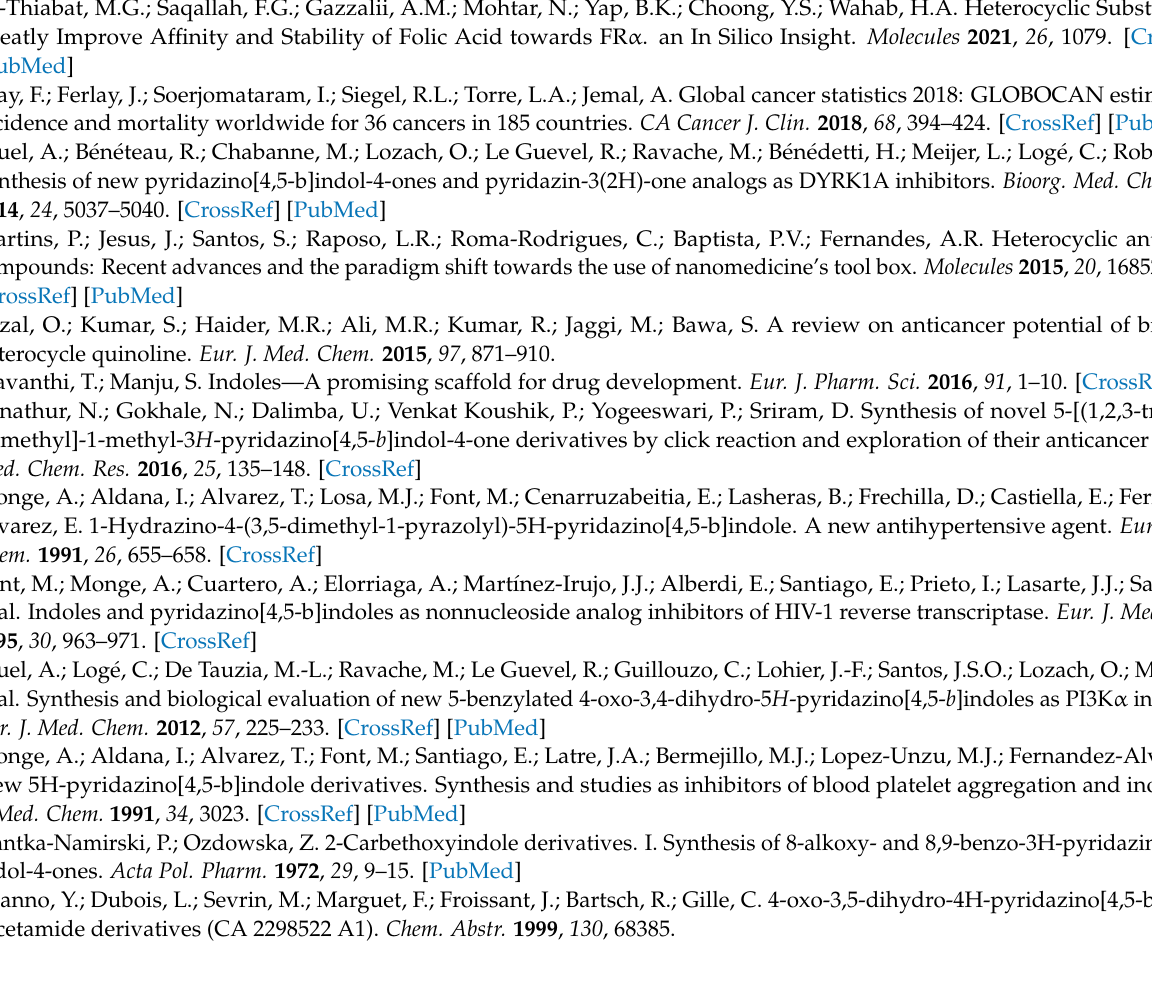
2 ; Figure S2: 13 C NMR of 2 ; Figure S3: 1 H NMR of 3 ; Figure S4; 13 C NMR of 3 ; Figure S5: 1 H NMR of 4 ; Figure S6: 13 C NMR of 4 ; Figure S7: 1 H NMR of 5 ; Figure S8: 13 C NMR of 5 ; Figure S9: 1 H NMR of 6 ; Figure S10: 13 C NMR of 6 ; Figure S11: 1 H NMR of 7 ; Figure S12: 13 C NMR of 7